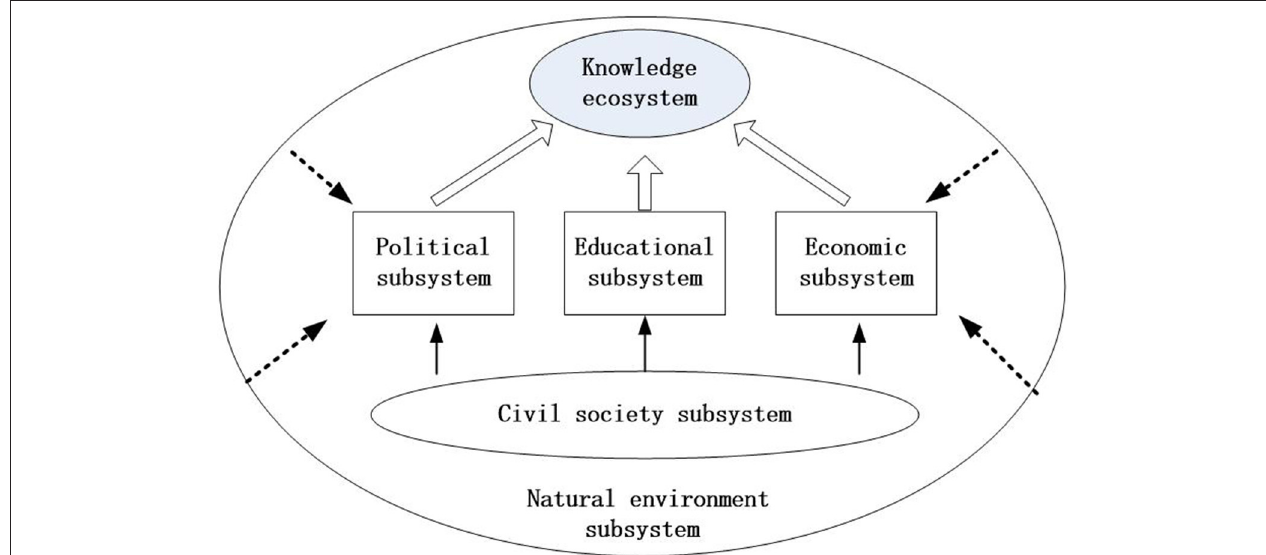
FIGURE 5 | The relationship of knowledge ecosystem and